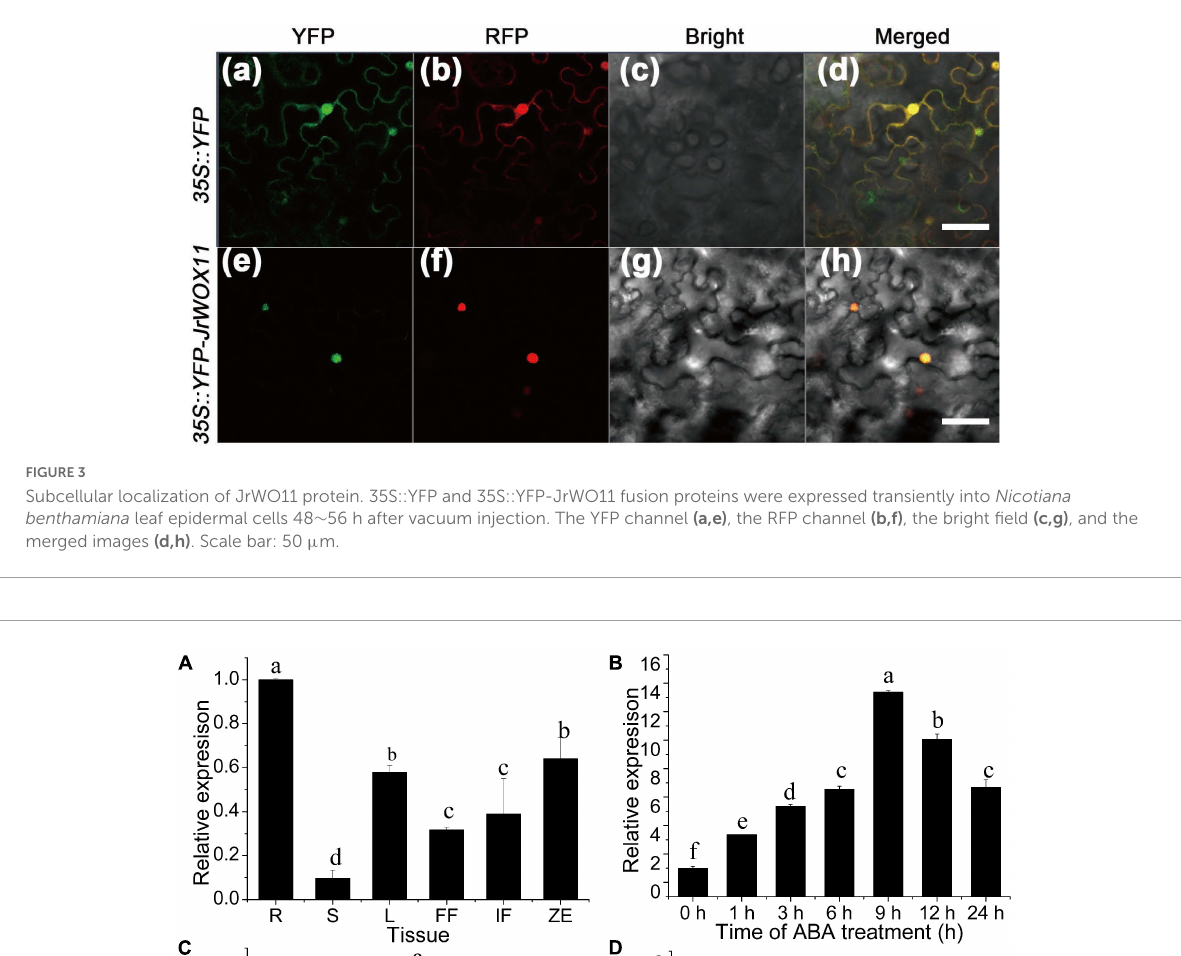
two OE lines (3# and 6#) were analyzed ( Figures 6A–C